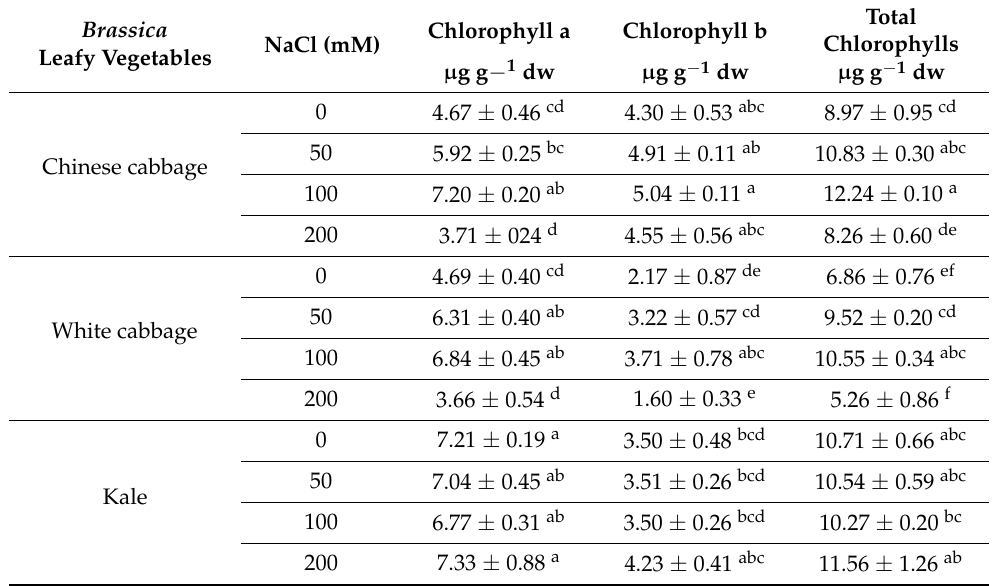
Table 1. Chlorophyll contents in Brassica leafy vegetables (Chinese cabbage, white cabbage, and kale) upon salinity treatments (0–200 mM NaCl). Data labeled with different letters (a–e) differed significantly at p < 0.05 in each